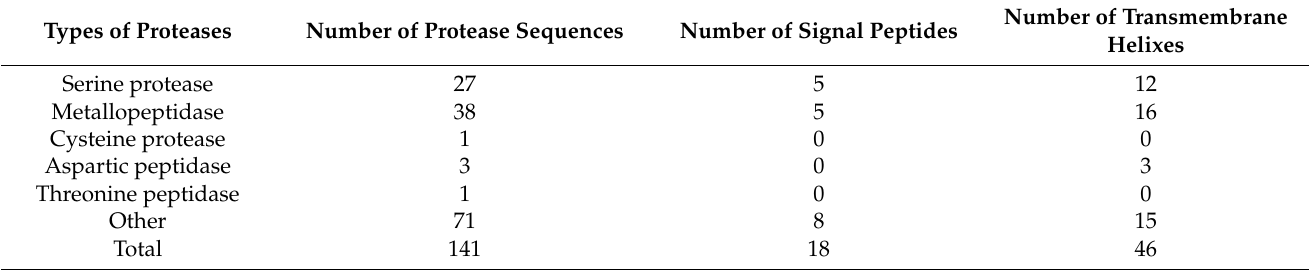
Table 3. Basic characteristics of proteases in the genome of G. stearothermophilus H6.